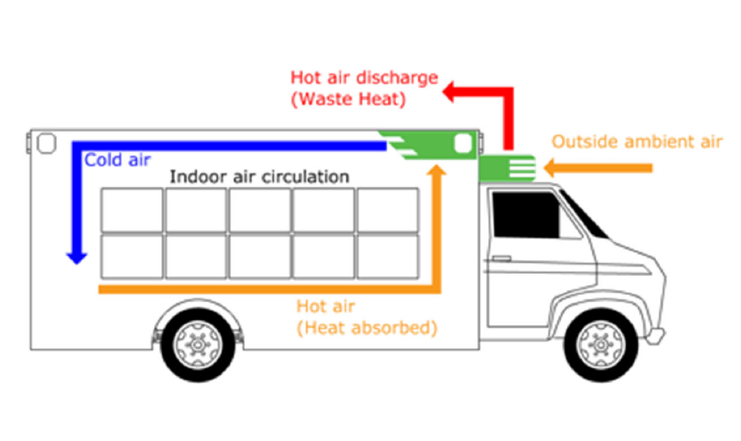
Fig. 2. Air flow into the vehicle (Source: